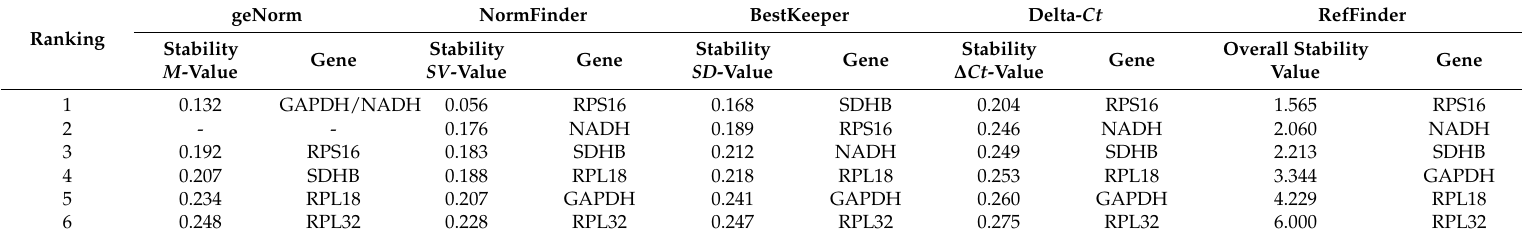
Table 2. Ranking of candidate reference genes according to stability values evaluated in a pool of A. sexdens biological samples.